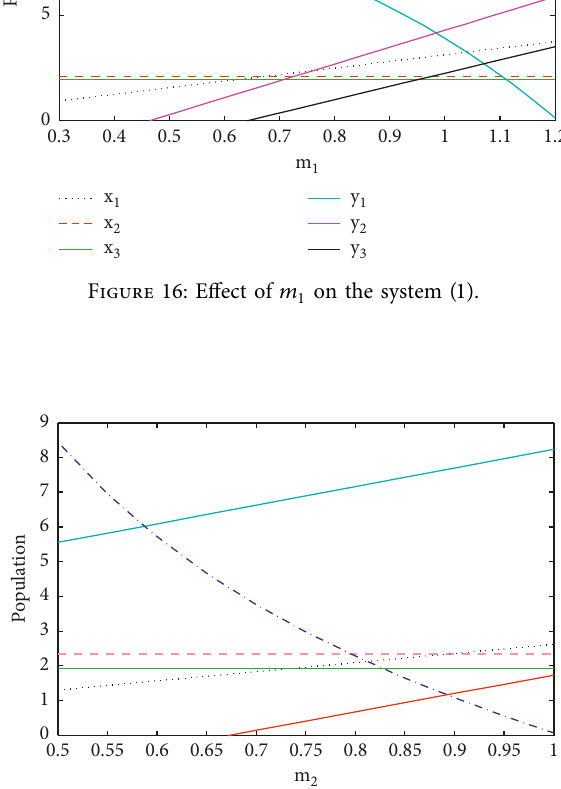
Figure 11 reflects the stable behavior of the proposed prey-predator system in the presence of dispersal. Here we found that each of the species of system (1) gradually converges to the inner equilibrium point E resses. This observation concludes that the proposed system Figure 17: Effect of m (1) persists in the presence of dispersal (Theorem 4). on the system (1). 2